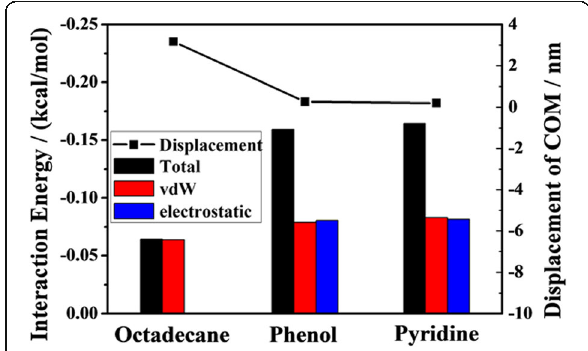
Fig. 8 The COM displacements of oil at 2 ns and average interaction energies (total, vdW, and electrostatic) between the different components and the